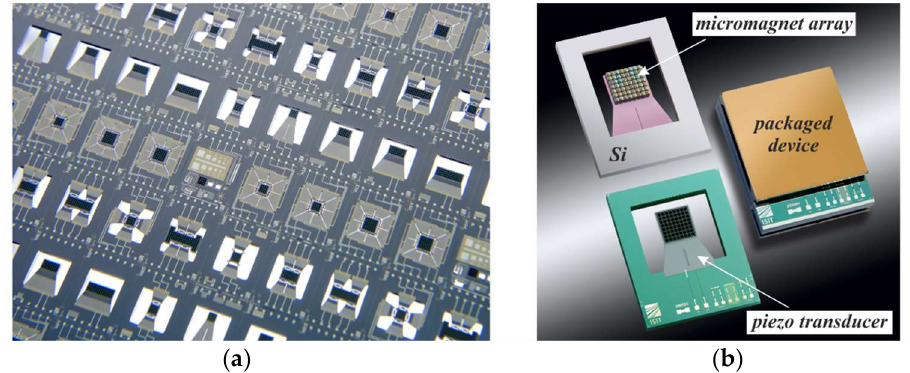
Figure 13. ( a ) Wafer with piezoelectric vibrational harvesters with integrated micromagnet arrays. ( b ) Detailed views of a single energy harvester from the top (lower left) and the bottom (upper left), as well as a packaged device.